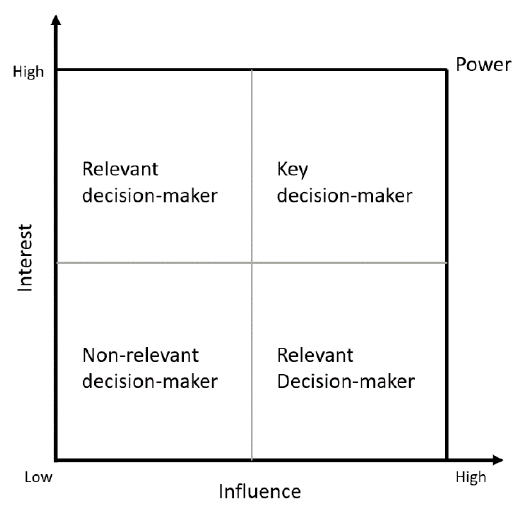
Figure 1. Parameters identifying relevant decision-makers.